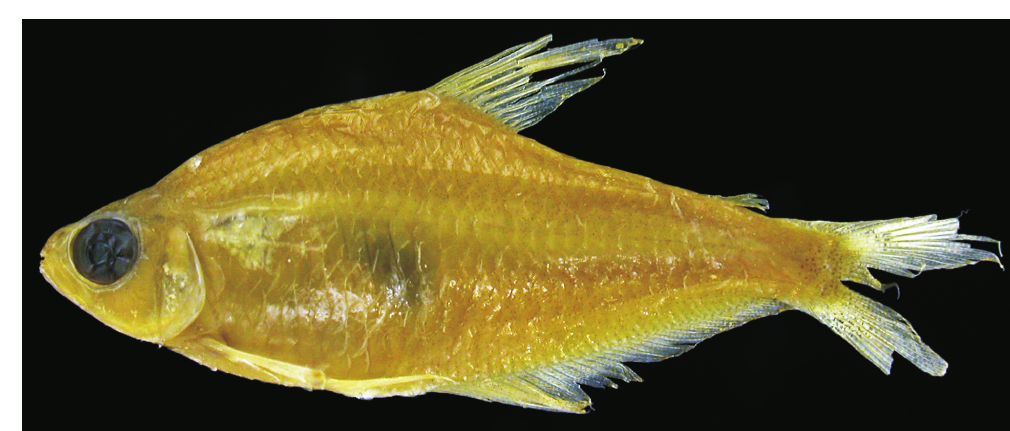
Figura 2. Phenacogaster capitulatus sp. nov. , MUSM 20424, holótipo, 38,7 mm CP, afluente do Rio Neshuya, Peru.